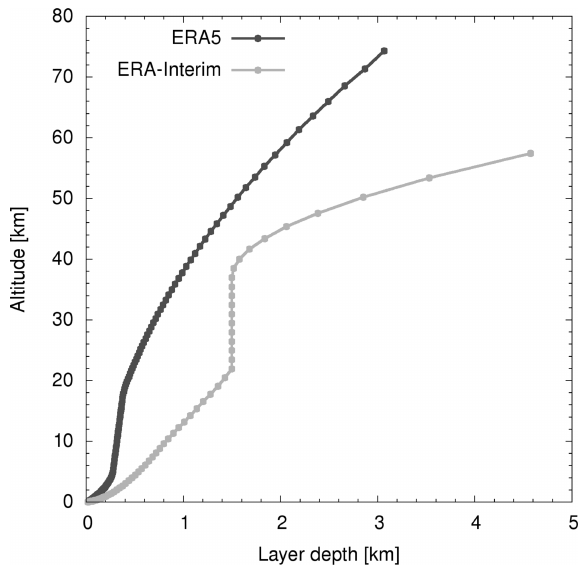
Figure 1. Vertical coverage and sampling of the ERA-Interim (light gray) and ERA5 (dark gray) reanalyses. Shown are layer depths and mid-layer altitudes calculated by means of the barometric for- mula using a constant scale height of 7km and a surface pressure of